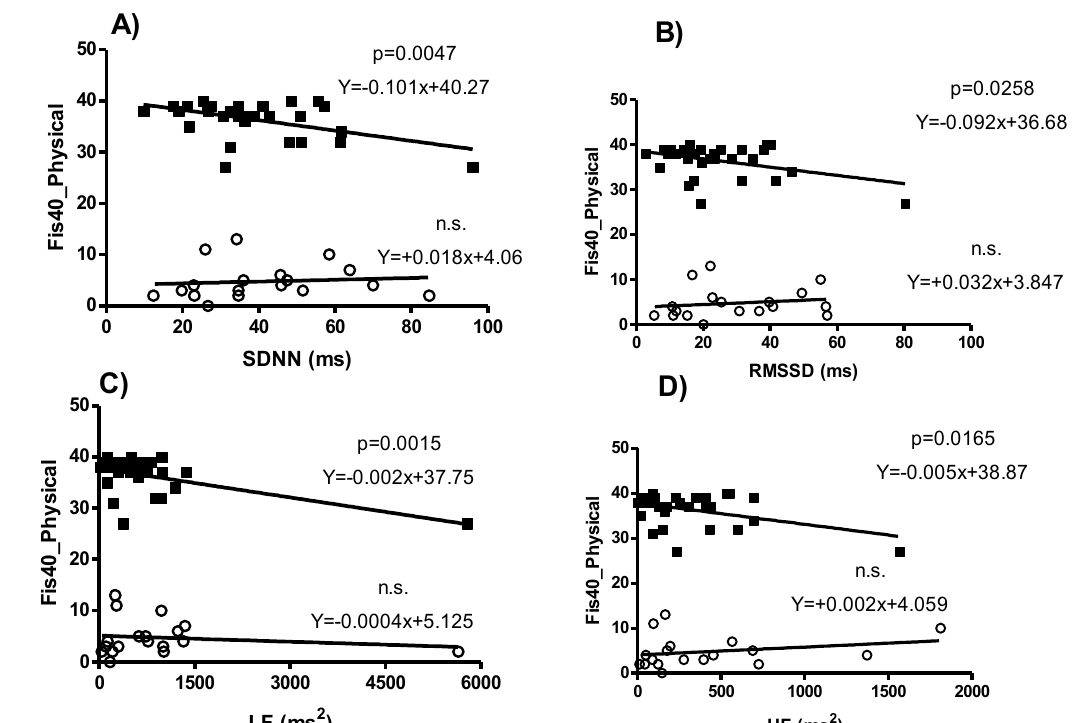
Figure 2. Simple regression analysis between physical fatigue perception (FIS-40) and HRV parameters differentiating ME/CFS patients ( n = 32) and Control men ( n = 19). Physical FIS-40 score is significantly explained from ( A ) SDNN ( p = 0.005), ( B ) RMSSD ( p = 0.026), ( C ) LF ( p = 0.002), and ( D ) HF ( p = 0.016), for ME/CFS patients (black squares, upper regression lines), but not for those healthy controls (white circles, bottom regression lines).